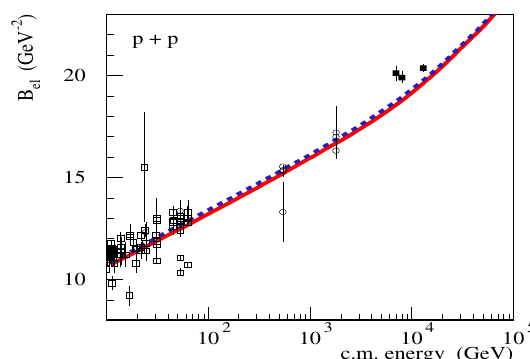
Figure 10. Energy-dependence of the calculated forward elastic scattering slope for pp collisions, for the parameter sets corresponding to the soft-hard separation scales Q 2 = 1.5 GeV 2 (dashed line). The experimental data are from Refs. [45–48]. Q 2 0